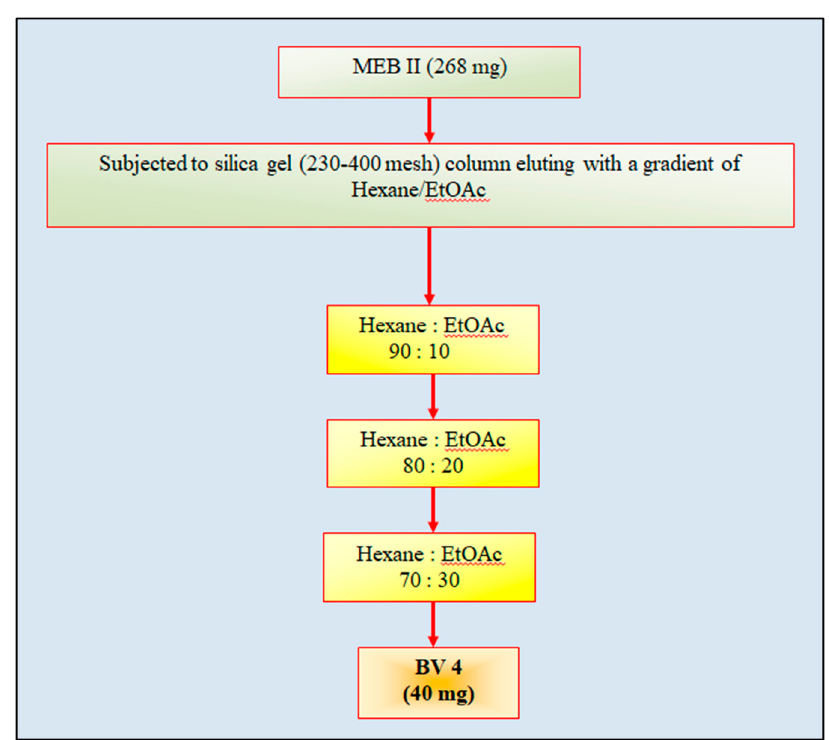
Figure 3. Column chromatography of fraction MEB II obtained from column chromatography of methanol extract (MEB) of bark of Bauhinia variegata L. BV4 is the pure fraction obtained, subjected to further characterization.